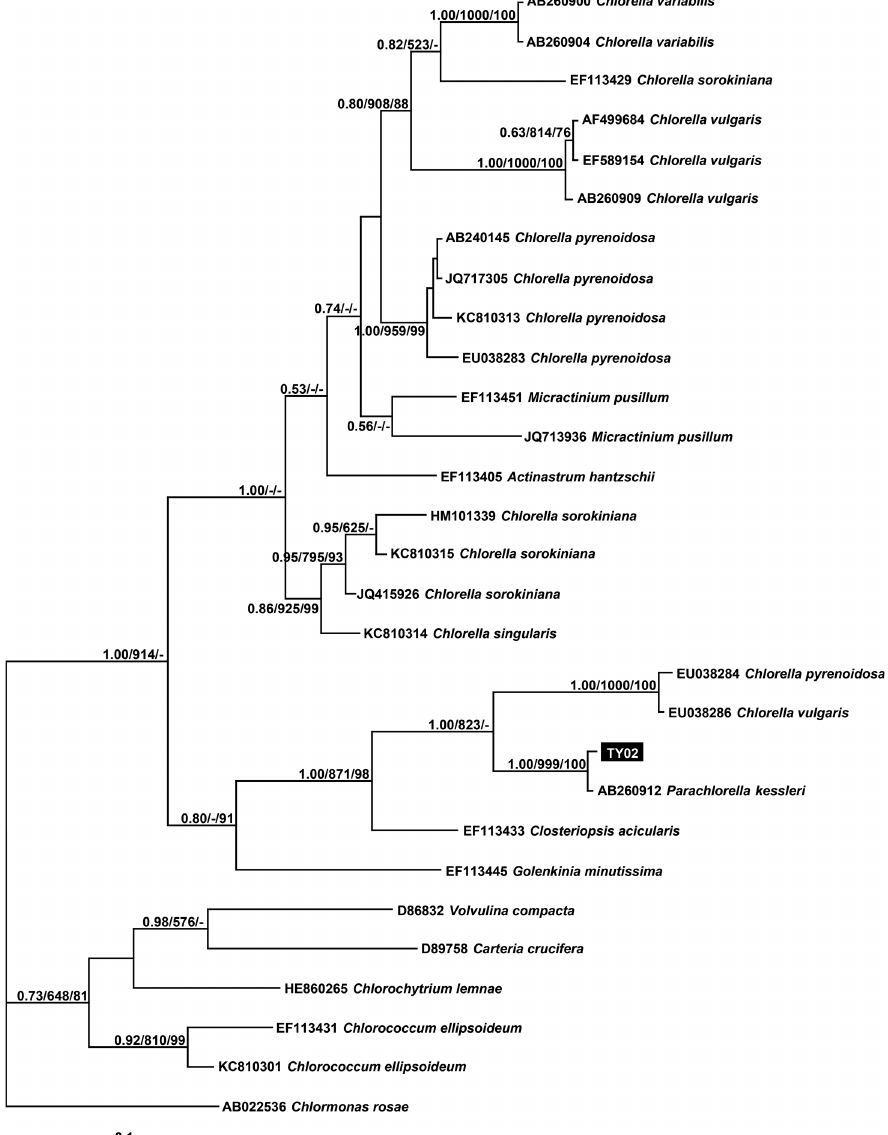
Fig. 8: Bayesian analysis tree based on rbc L gene sequence. The numerical values at the nodes represent the support values of BI bootstrap/ML bootstrap/NJ bootstrap. Values <50% are not shown.